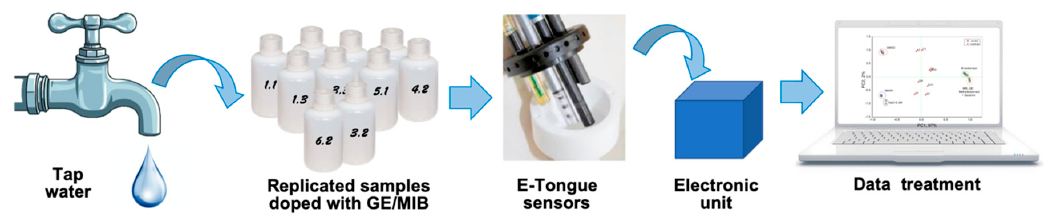
Figure 2. Schematic presentation of the employed measurement system.